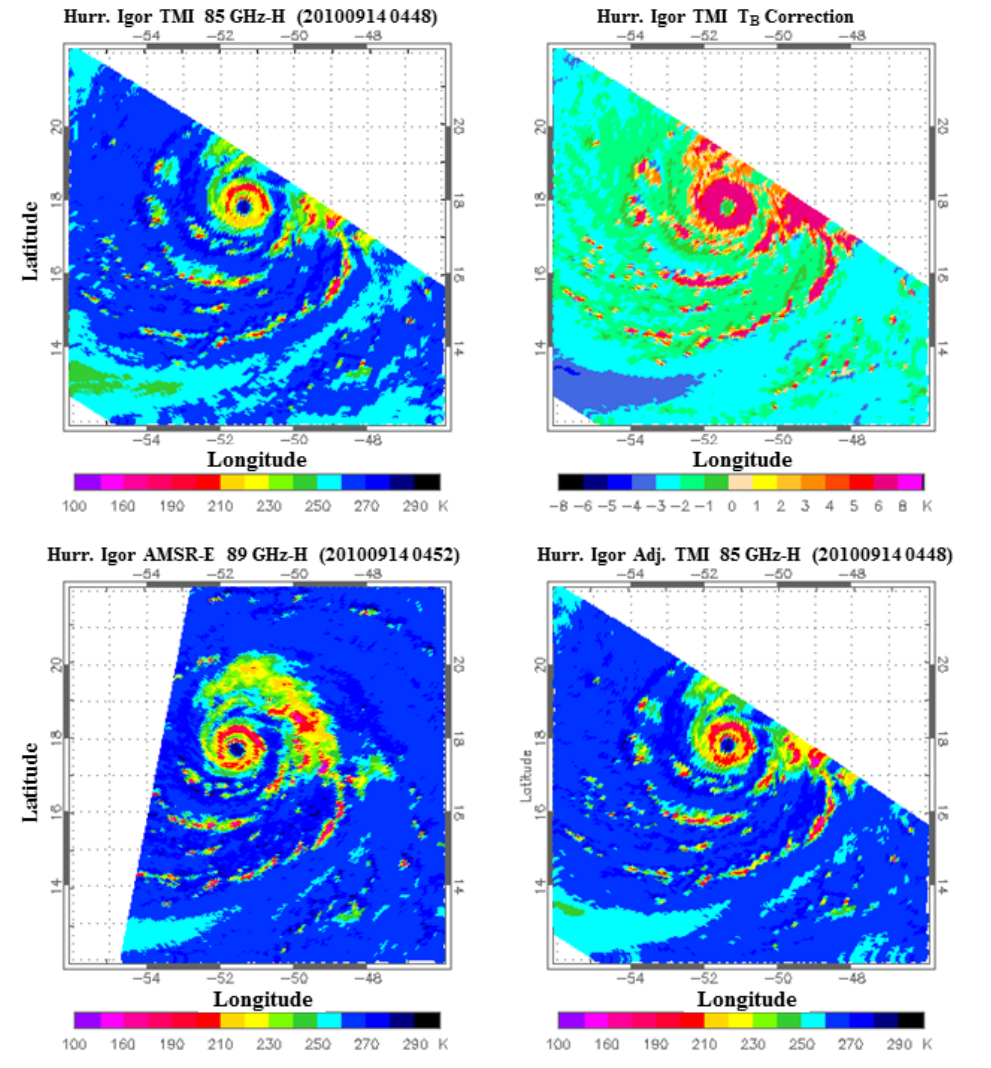
Figure 10. Impact of the newly developed physically-based calibration scheme on hurricane Igor: ( upper-left panel ) original TMI 85 GHz-H; ( bottom-left panel ) original AMSR-E at 89 GHz-H; ( upper-right panel ) T ( bottom-right panel ) calibrated TMI 89